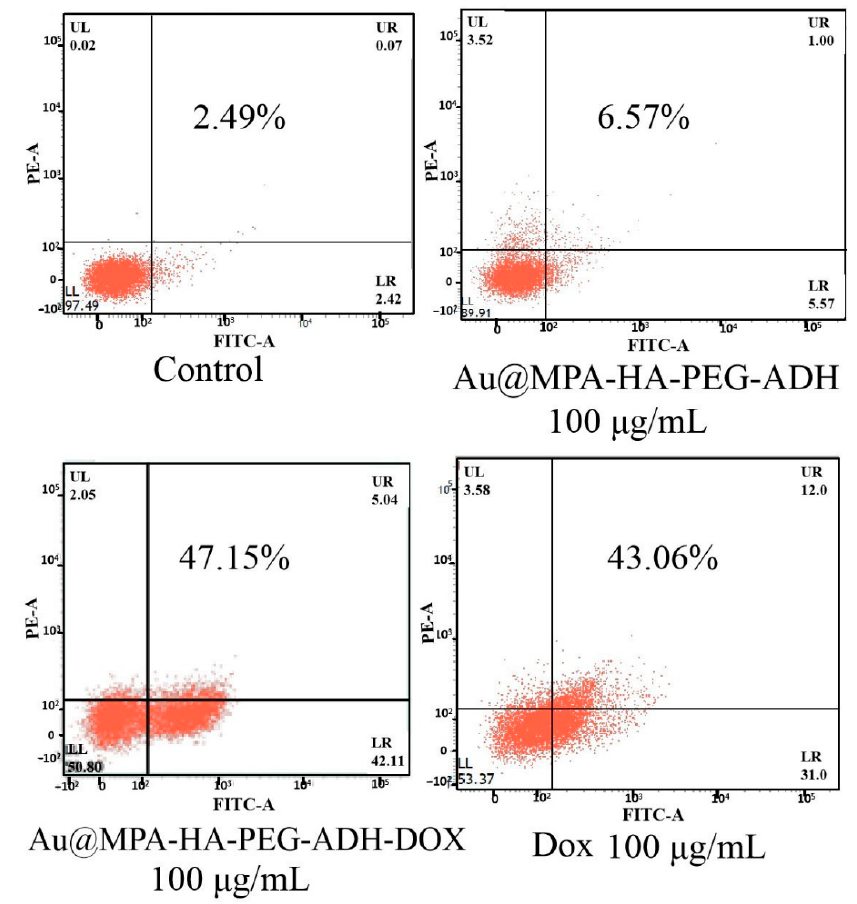
Figure 6. Analysis of apoptosis analysis in HepG2 cells treated with Au@MPA-PEG-HA-ADH, Au@MPA-PEG-HA-ADH-Dox, and Dox using flow cytometry (Annexin V-FITC staining).